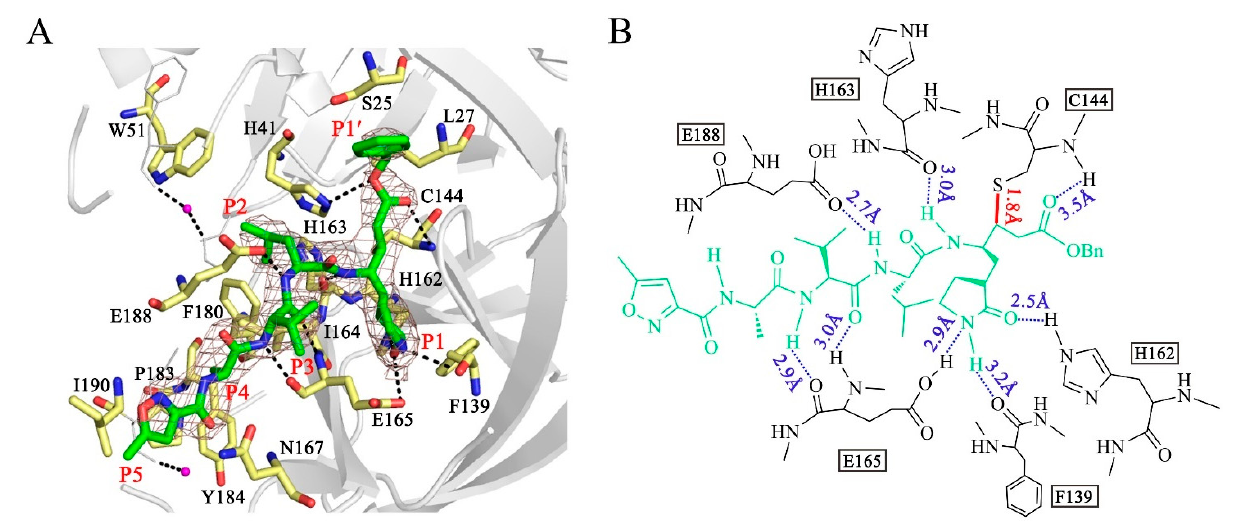
Figure 3. Structure of the interaction between N3 and PDCoV M pro . ( A ) Stereoview of N3 bound to the substrate-binding pocket of PDCoV M pro . N3 is colored green and shown with a simulated annealing 2mFo-DFc omit map contoured at 1.0 σ . The residues at the substrate-binding pocket that contribute to the interaction between N3 and PDCoV M pro are shown in yellow. Waters are shown in magenta. The P1 ′ , P1, P2, P3, P4 and P5 sites are labeled. ( B ) Detailed interactions between PDCoV M pro and N3. N3 is shown in green. Hydrogen bonds are shown as blue dashed lines. The covalent bond formed by N3 and the S γ atom of Cys-144 is shown as a solid red line.